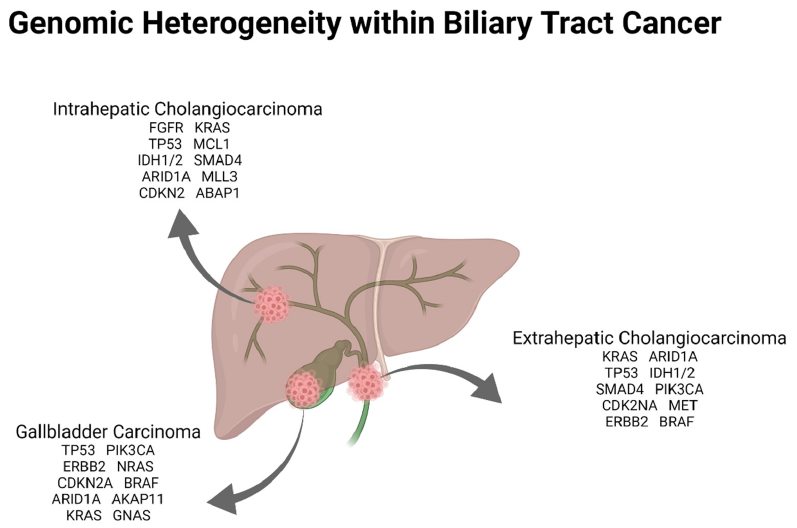
Figure 2. Most common genomic alterations identified based on anatomic location of biliary tract cancer. Frequency of alterations listed is based on Nakamura et al. Nat. Genet. 2015 [10], Lowery et al. Clin. Cancer Res. 2018 [12], Javle et al. Cancer 2016 [13] and Wardell et al. J. Hepatol. 2018 [11].